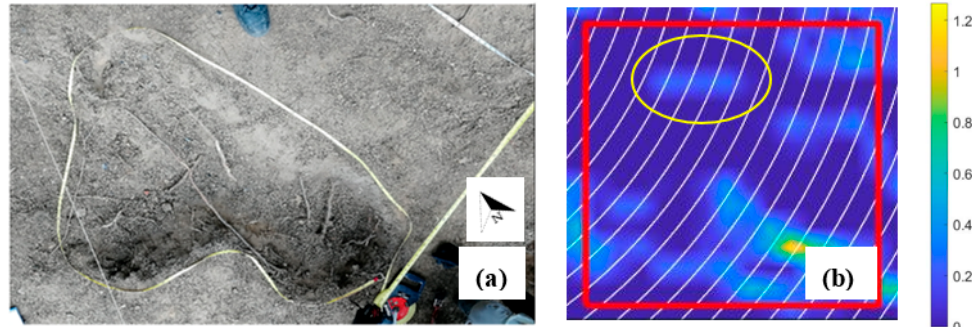
Figure 19. ( a ) The excavated root cluster, and ( b ) a close-up view of the 0.20–0.30 m density map. The yellow circle highlights an area with increased density, corresponding to the cluster of roots.